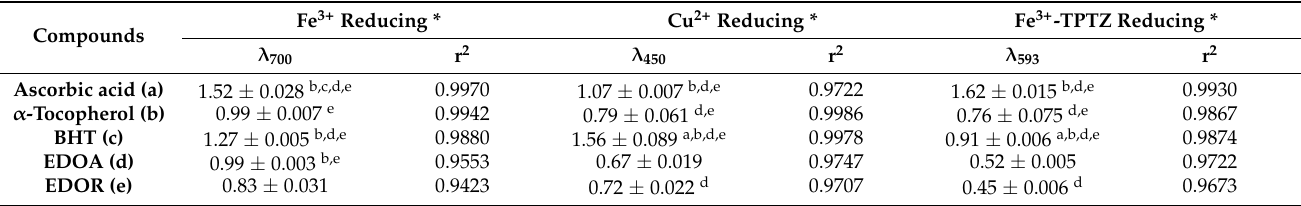
Table 2. The reducing abilities of ethanol extract of aerial parts (EDOA) and roots (EDOR) of sahlep ( D. osmanica ) and standards.